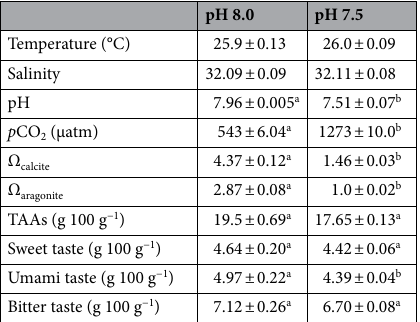
Table 1. Temperature, salinity, pH, p CO 2 , saturation state for calcite (Ω calcite ) and aragonite (Ω aragonite ), total amino acids (TAAs) in tiger shrimp, and total amino acid concentration in each of the three taste classes at pH 8.0 and 7.5.